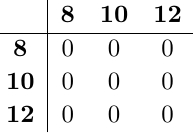
Table H.1. Average Hellinger distances between any two topics paths generated using various neighborhood parameters k as the column/row indices. Examples are shown for the COVID (health care) topics. Note that the average Hellinger distances are identically 0 across all pairs of paths, indicating that the shortest paths are stable under different choices of k